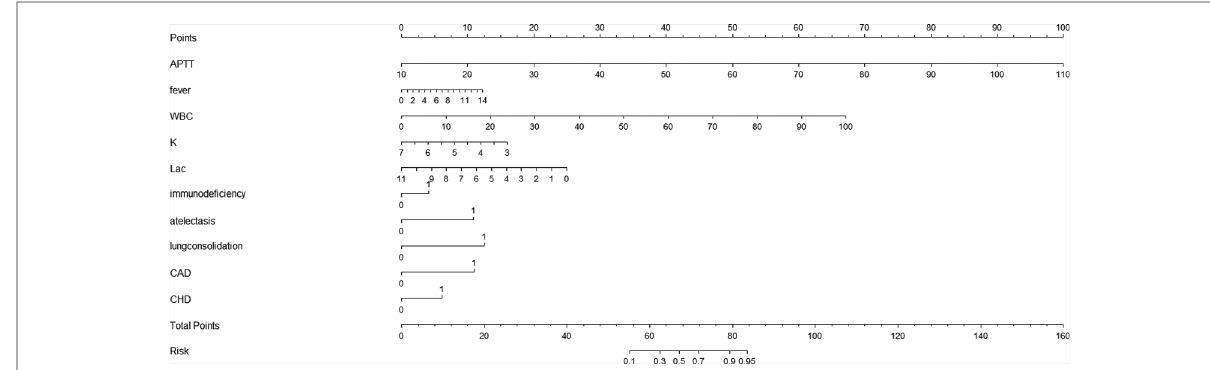
FIGURE 2 Nomogram for prediction of CPAP treatment for bronchiolitis.